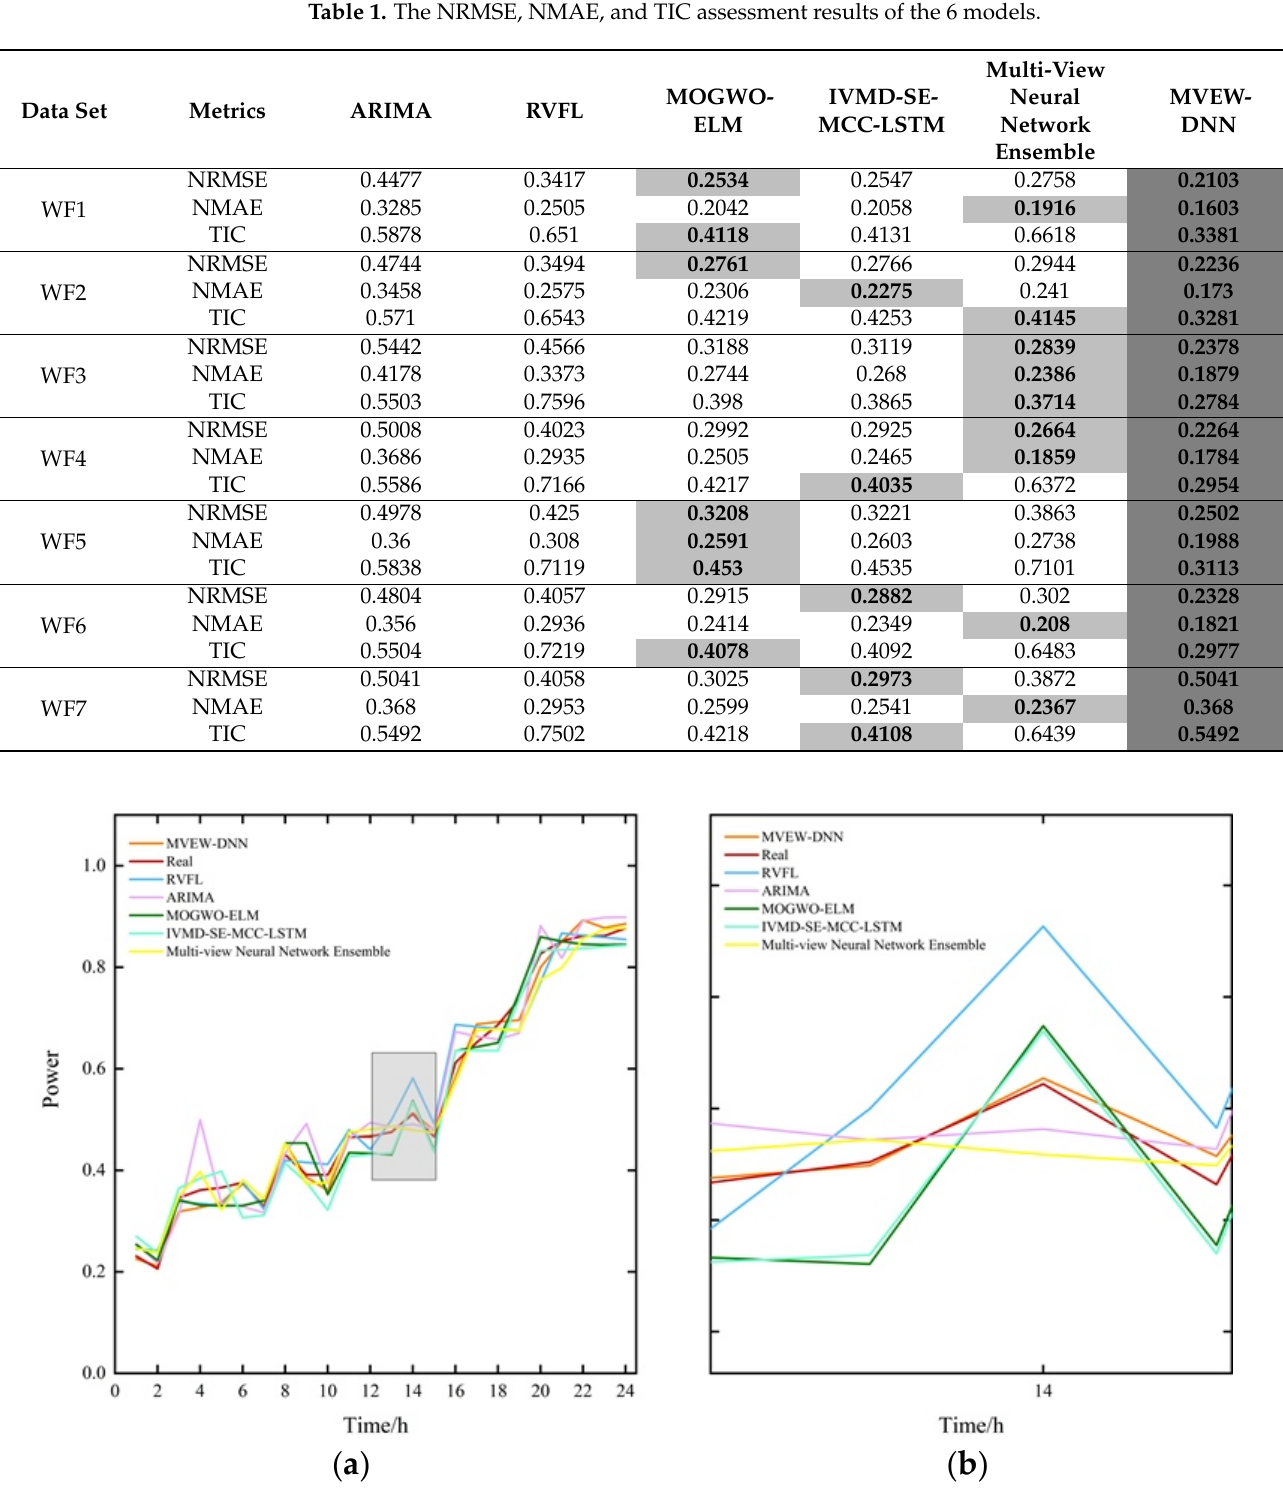
Figure 4. The prediction results are executed by the above models with the data set from WF3. ( a ) Prediction results from 6 models for WF3 wind power data forecasted 24-h in advance. ( b ) Partial enlargement of the 6 model predictions. Table 1. The NRMSE, NMAE, and TIC assessment results of the 6 models.